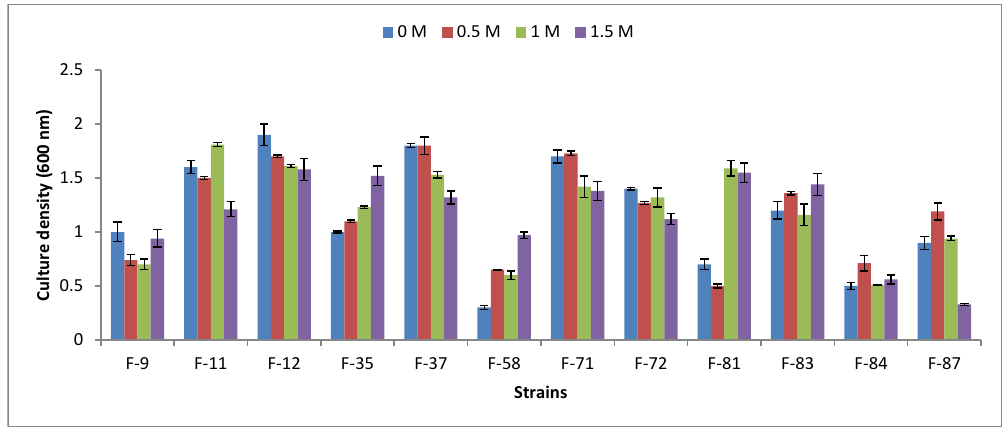
Figure 2. Halophility assay of salt-tolerant rhizobacteria in the presence of different concentrations of NaCl. Bar represents mean ± SE of three replicates.